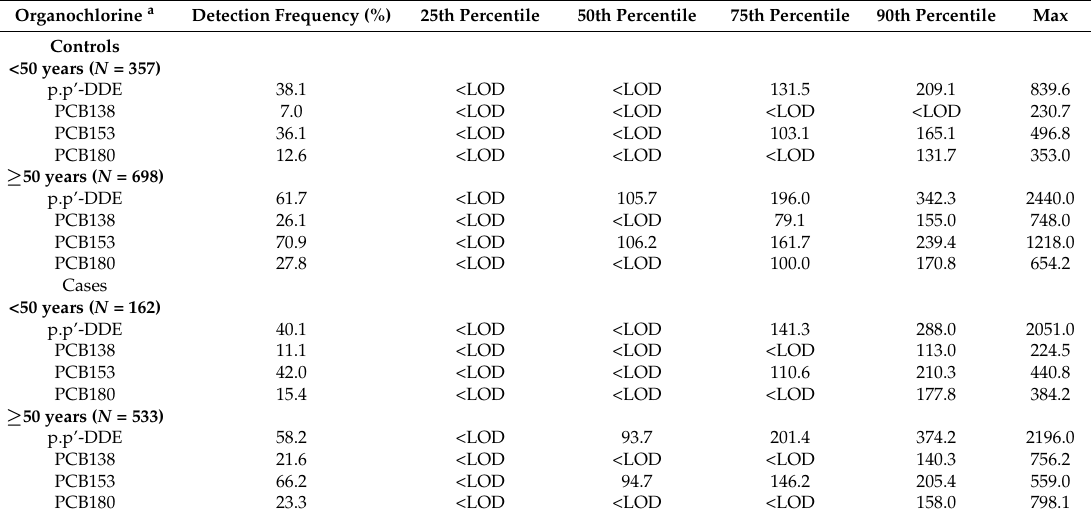
66.2 <LOD 94.7 23.3 <LOD <LOD <LOD 158.0